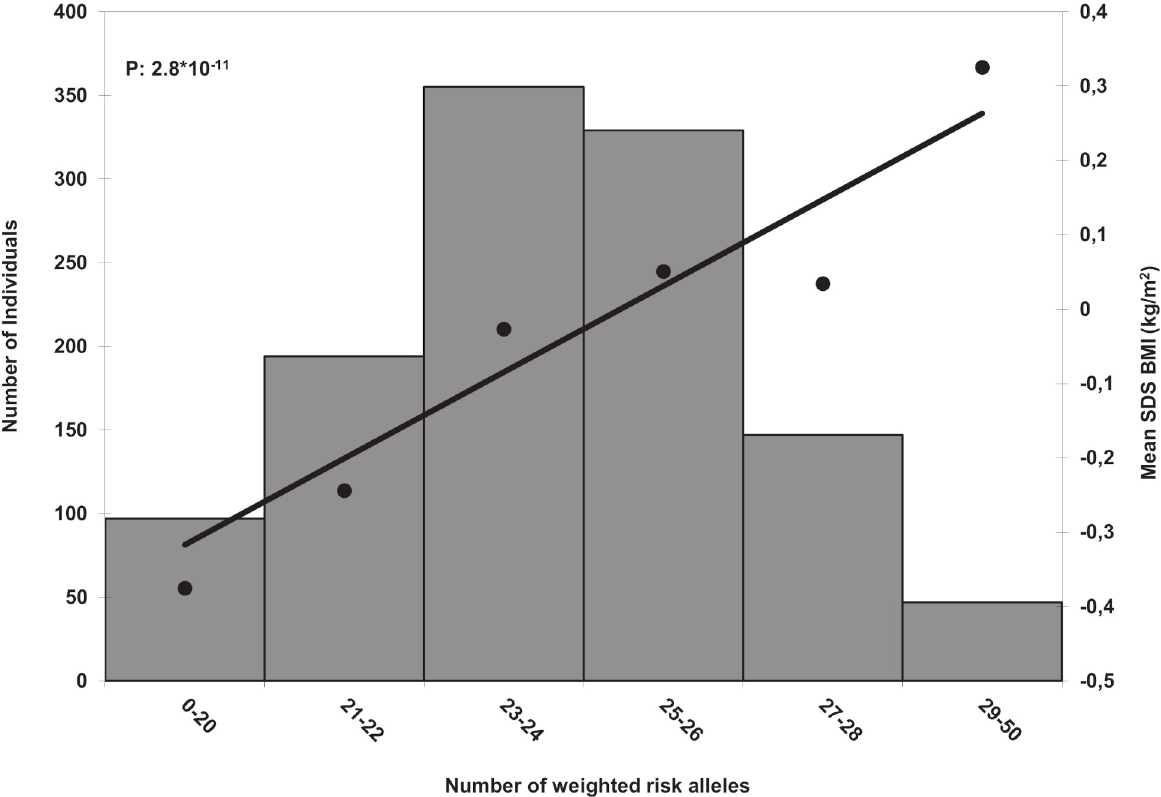
Fig 4. Associations of the weighted risk score with childhood BMI. Along the x-axis, categories of the risk score are shown together with the mean SDS BMI on the y-axis on the right and a line representing the regression of the mean SDS childhood BMI values for each category of the risk score. Along the y-axis on the left a histogram represents the number of individuals in each risk-score category. P-value is based on the continuous risk score. Analysis was performed in the TRAILS cohort (N = 1,169).